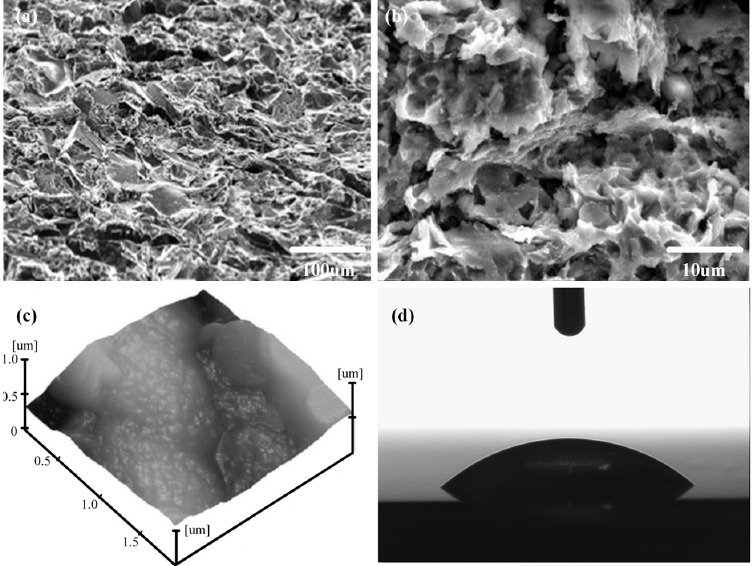
Figure 3. Images of SEM, AFM and a water droplet on the Al alloy surfaces after being treated by sandblasting. ( a ) SEM image with 200 magnification; ( b ) SEM image with 2000 magnification; ( c ) AFM image; ( d ) water droplets with a volume of 5 μ L.